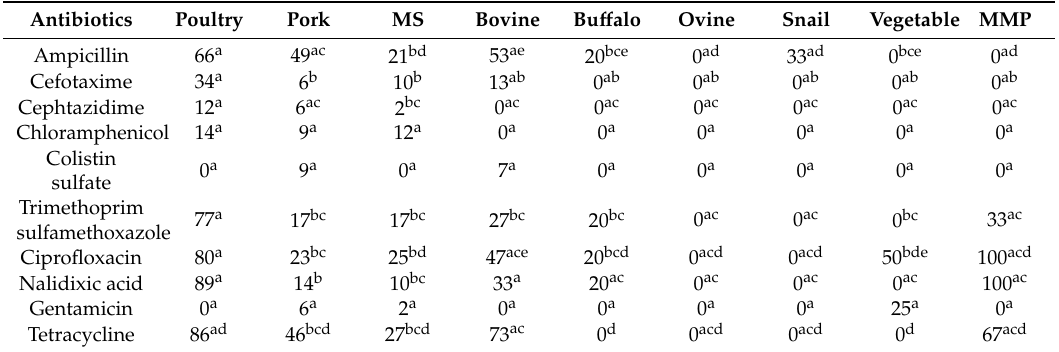
Table 1. Overall occurrence (%) of resistance (R) to 10 antimicrobials in Salmonella spp. from poultry (meat and meat products), pork (meat and meat products), molluscan shellfish (MS), bovine (meat and dairy products), bu ff alo (raw milk), ovine (raw milk), snail, vegetables, and mixed meat products (MMP, composed of a mix of di ff erent ingredients). Values in rows bearing di ff erent lowercase letters are significantly di ff erent ( p <